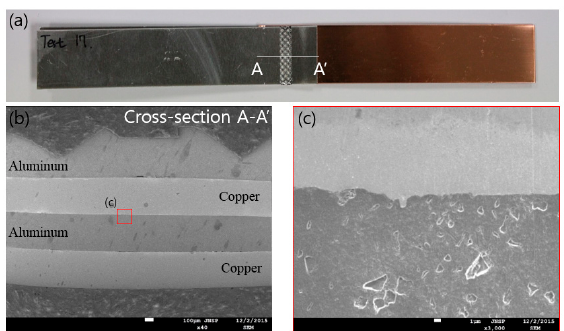
Figure 7. Cross-section ultrasonic weld zone with amplitude 70%, welding time 2.5 sec, and pressure load 3 bar: ( a ) cross-sectional cutting position; ( b ) joint cross section (x40); ( c ) joint cross section (x3000).